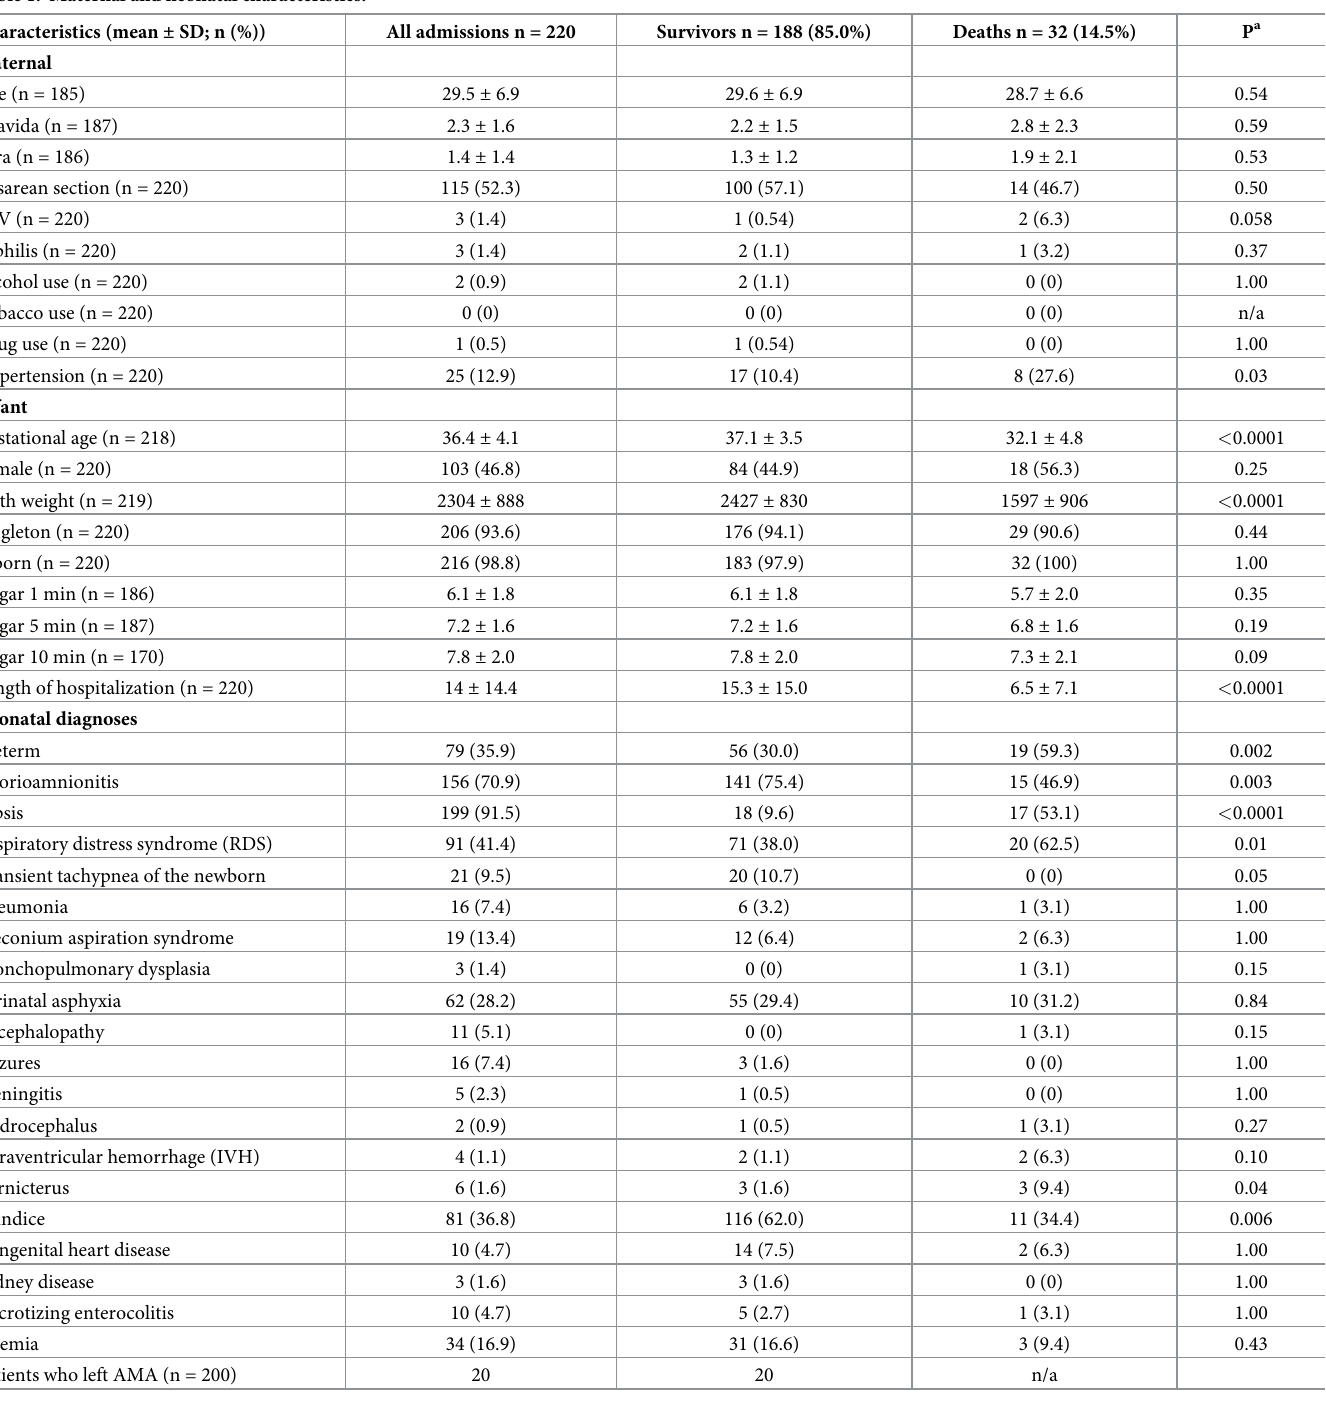
Table 1. Maternal and neonatal